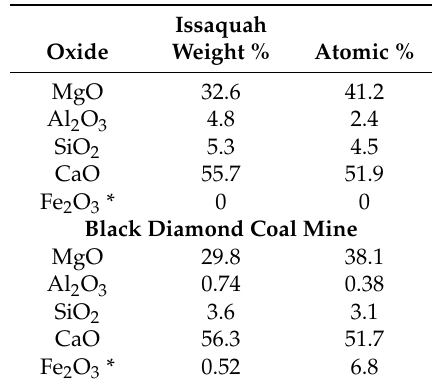
Table 2. Major element composition of dolomitized wood from Eocene Puget Group, King County, Washington, USA, determined by SEM/EDS.